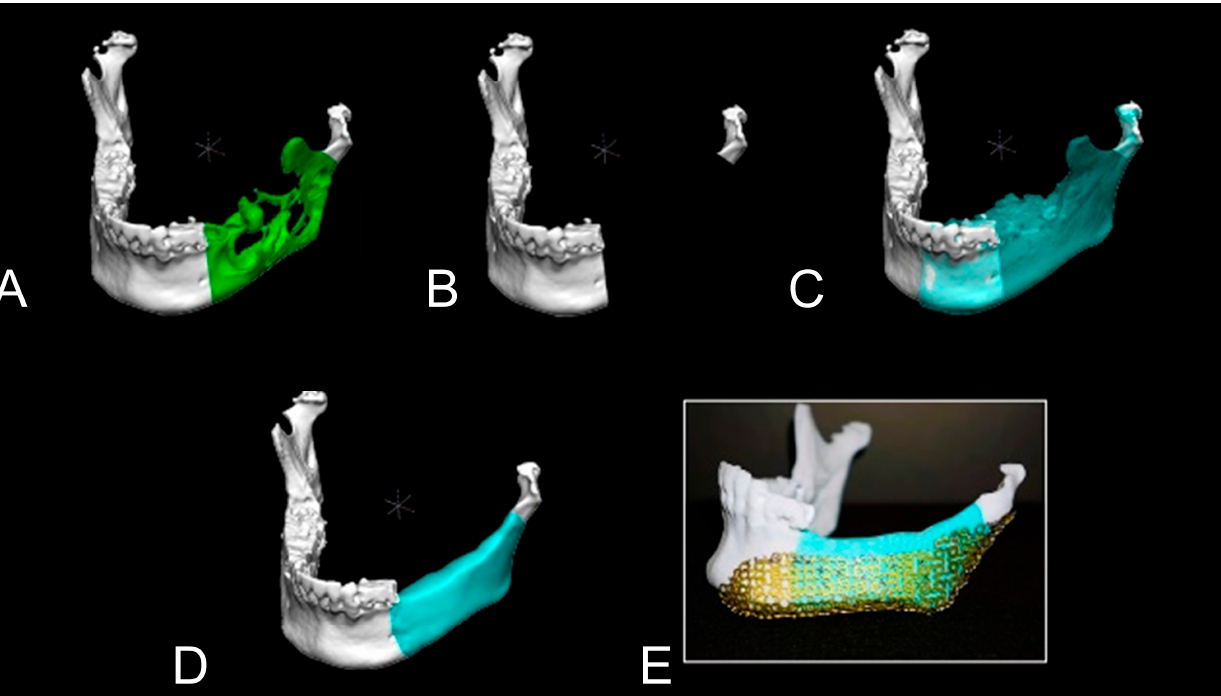
Figure 4. Simple mirroring technique. This case (Case 8) had ameloblastoma from the left mandib- ular body to ascending ramus ( A ). From the result of the preoperative imaging evaluation, the left condyle was intact. After determining the extent of the resection ( B ), the right jaw was mirrored ( C ). Then, bone augmentation was performed digitally ( D ). After that, the 3D model was produced and titanium mesh was pre-bended ( E ). mesh was pre-bended ( E